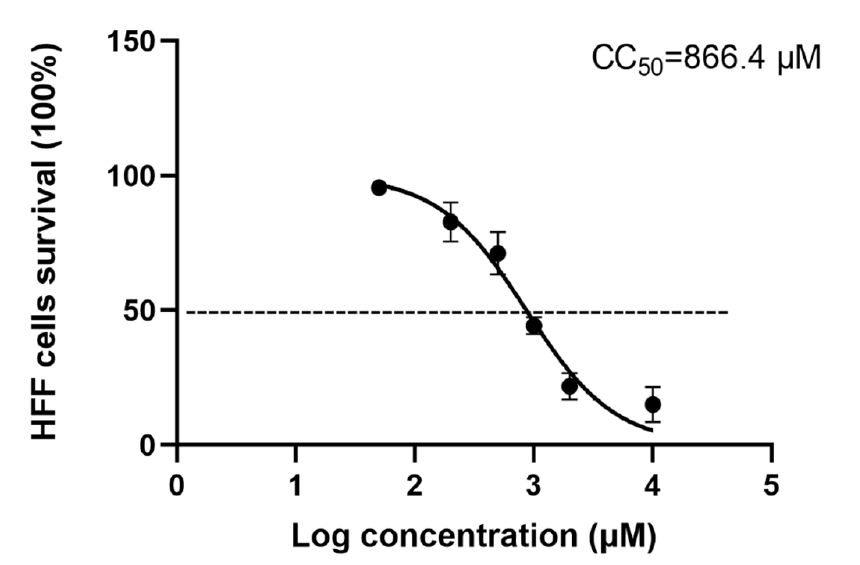
Figure 1. Cytotoxicity assay of artemether on HFF cells.